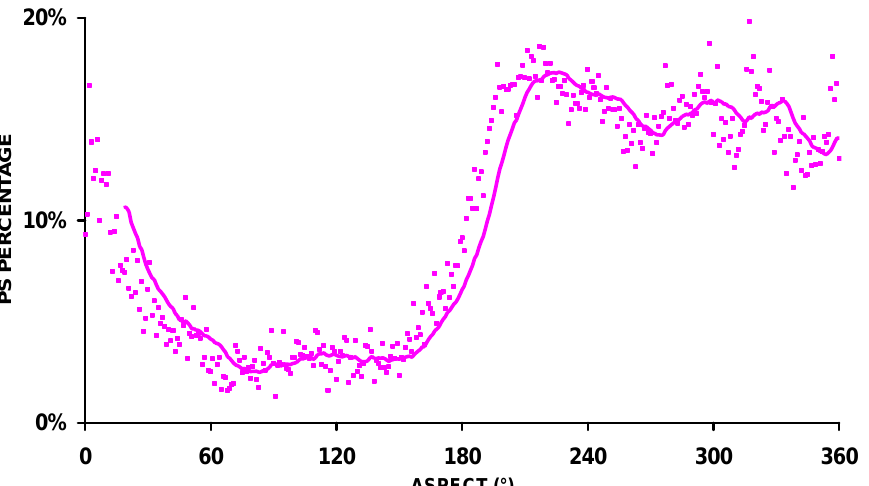
Figure 4. Descending PS on landslides vs.